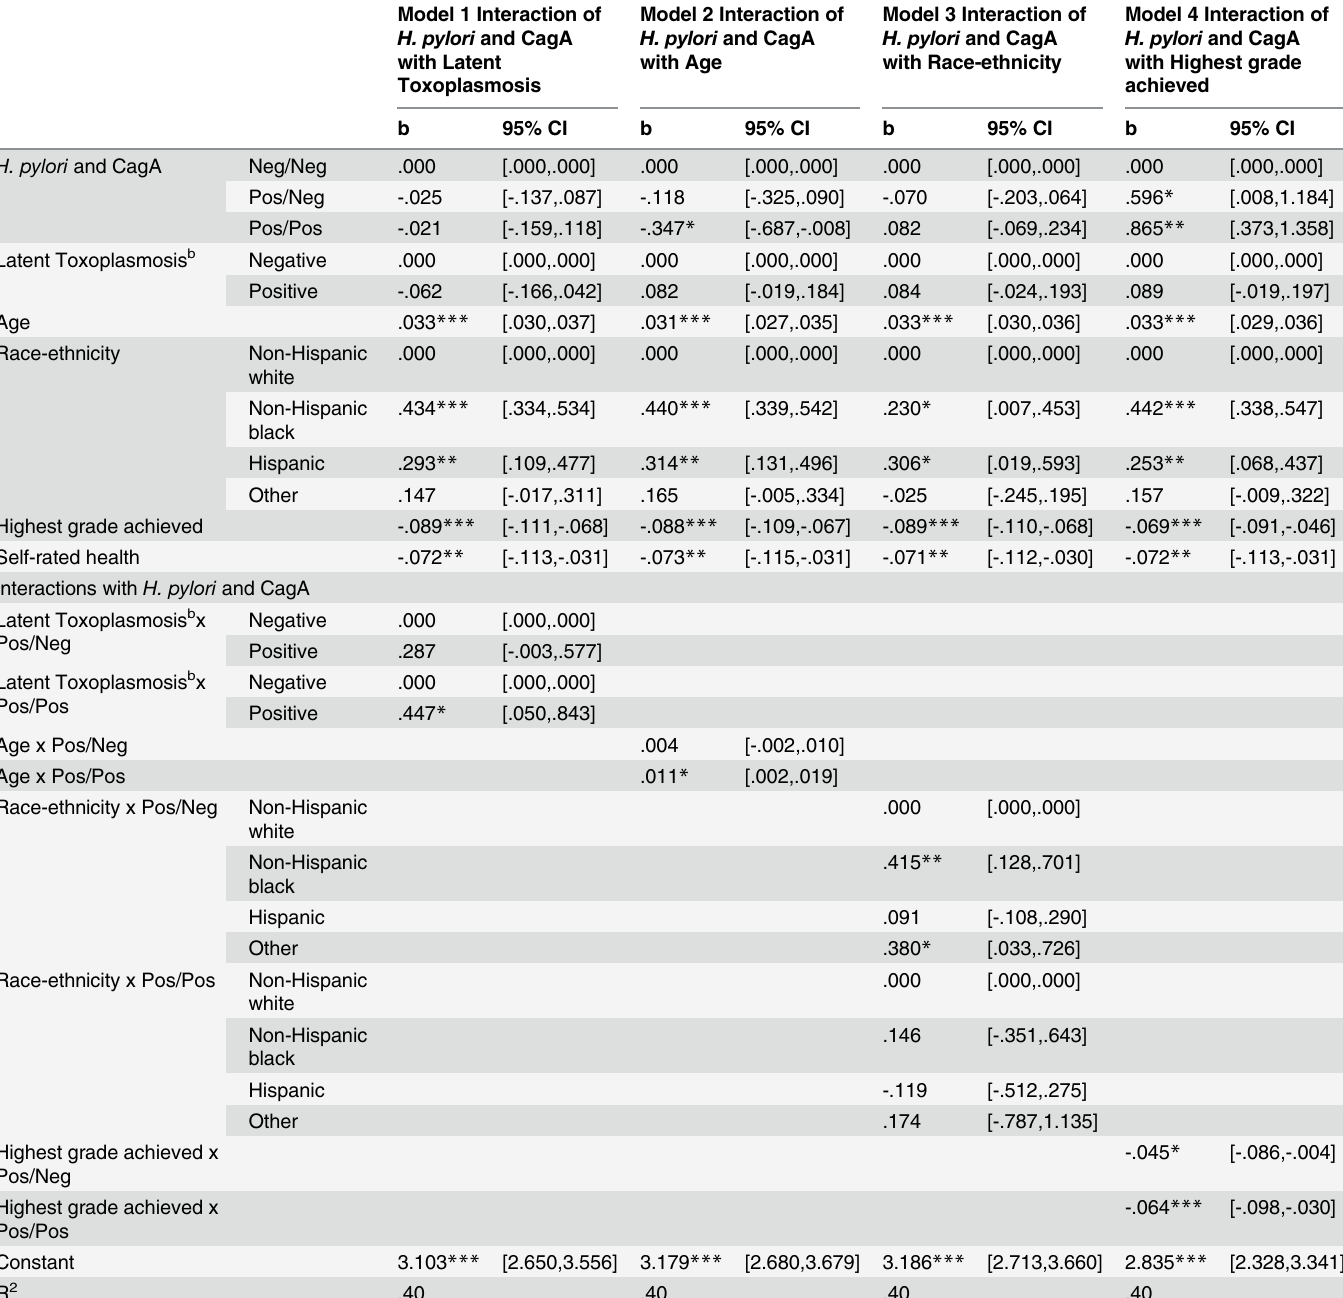
Table 4. Multivariate Analysis of the Symbol Digit Substitution Test with Interactions of H. pylori in US 21 to 59 Year-Olds, NHANES III (1988 – 1994): Unstandardized Coef fi cients [95% CI] from Weighted OLS Regression. Model 1 Interaction of H. pylori and